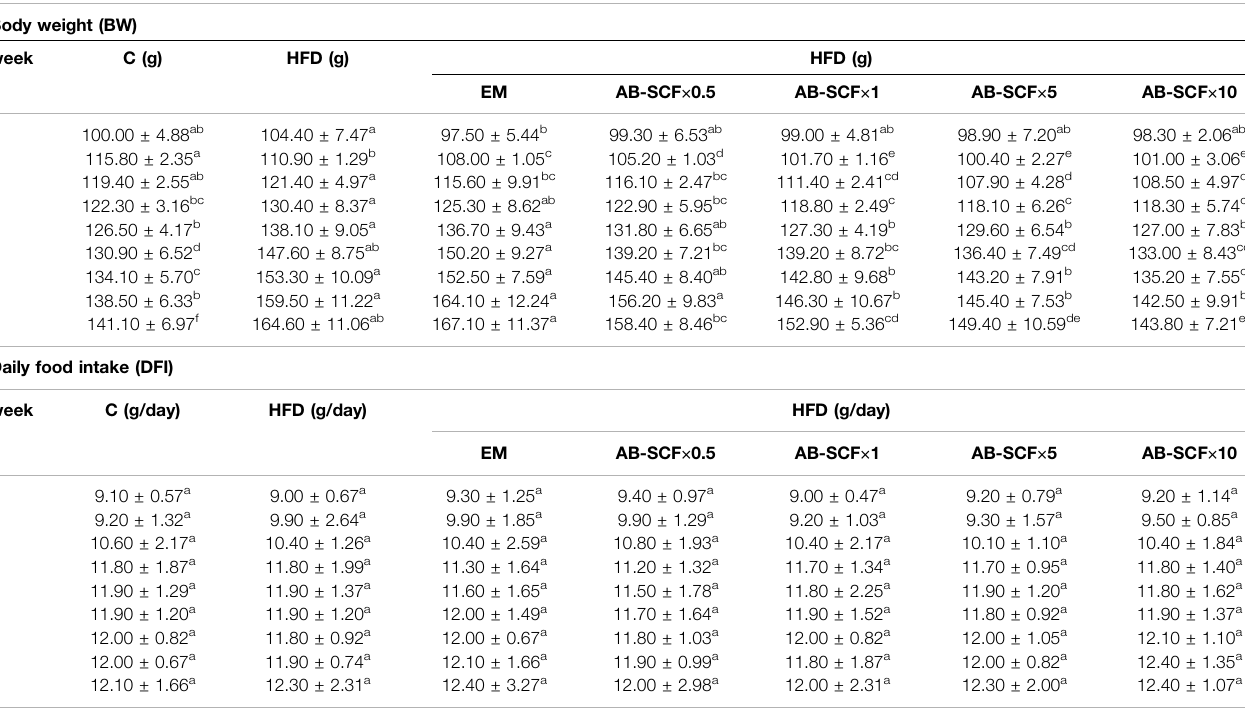
TABLE 1 | Body weight (BW) gains and daily food intake (DFI) among normal and hyperlipidemic hamsters administrated with